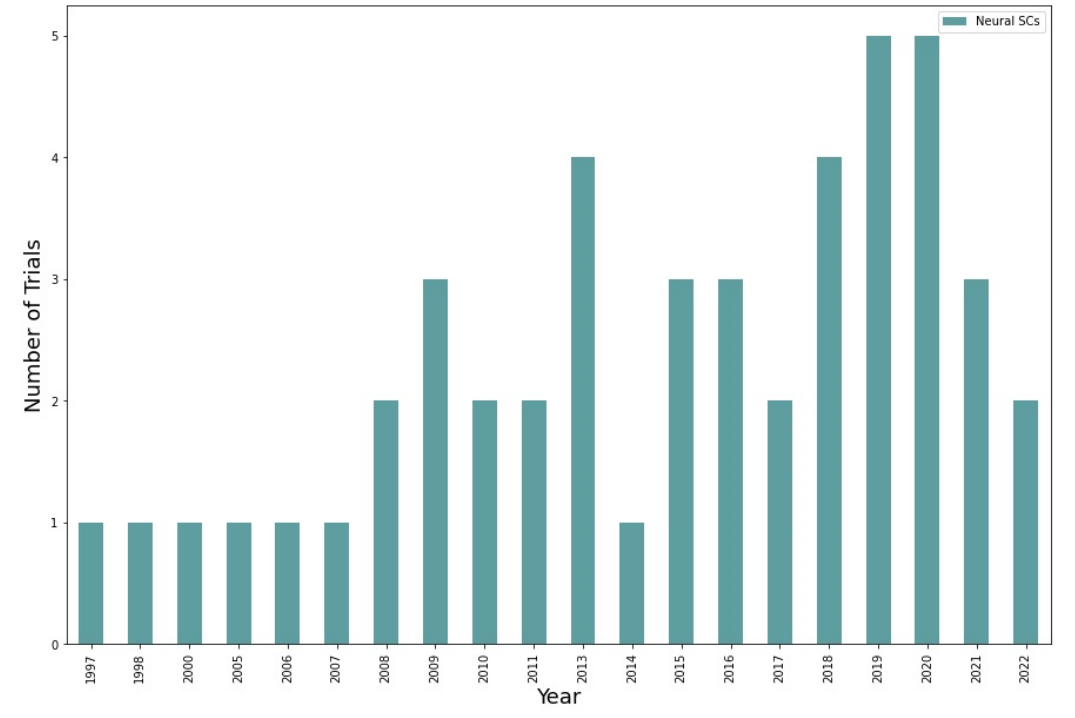
Figure 8. Neural stem cells clinical trials.